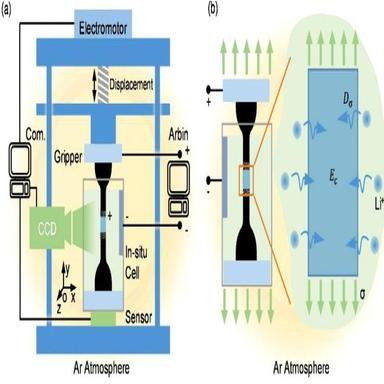
(a) The in-situ ECM characterization setup, including a homemade in-situ LIB, a miniature tensile-testing system, an optical system, and an electrochemical station (Arbin), enclosed in the glovebox filled by high purity Ar. (b) The ECM coupling effects in the Al foil electrode. The mechanical properties of material, such as elastic moduli, change with lithiation, while the electrochemical properties, such as diffusion processes of Li-ions in Al, are also influence by the stress inside Al matrix.